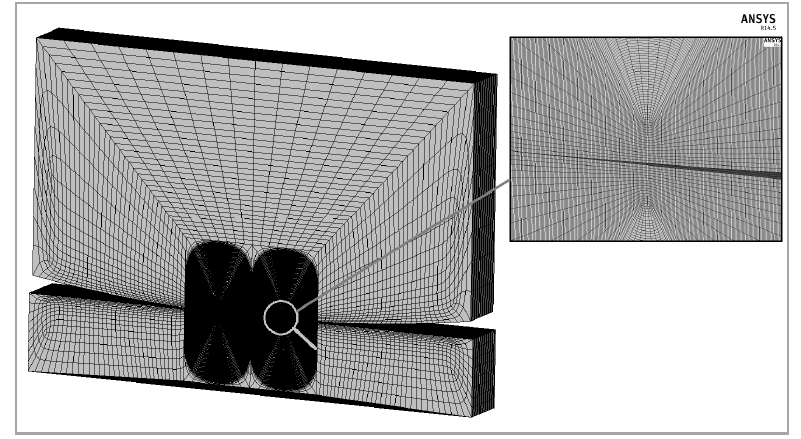
Figure 3: Mesh in the 3D